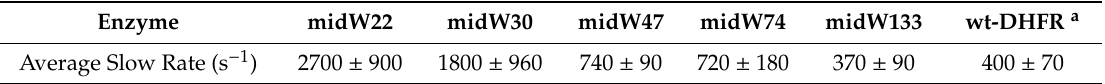
Table 4. Average relaxation rates of the slow phase for the binary folate complexes of all five midW mutants and